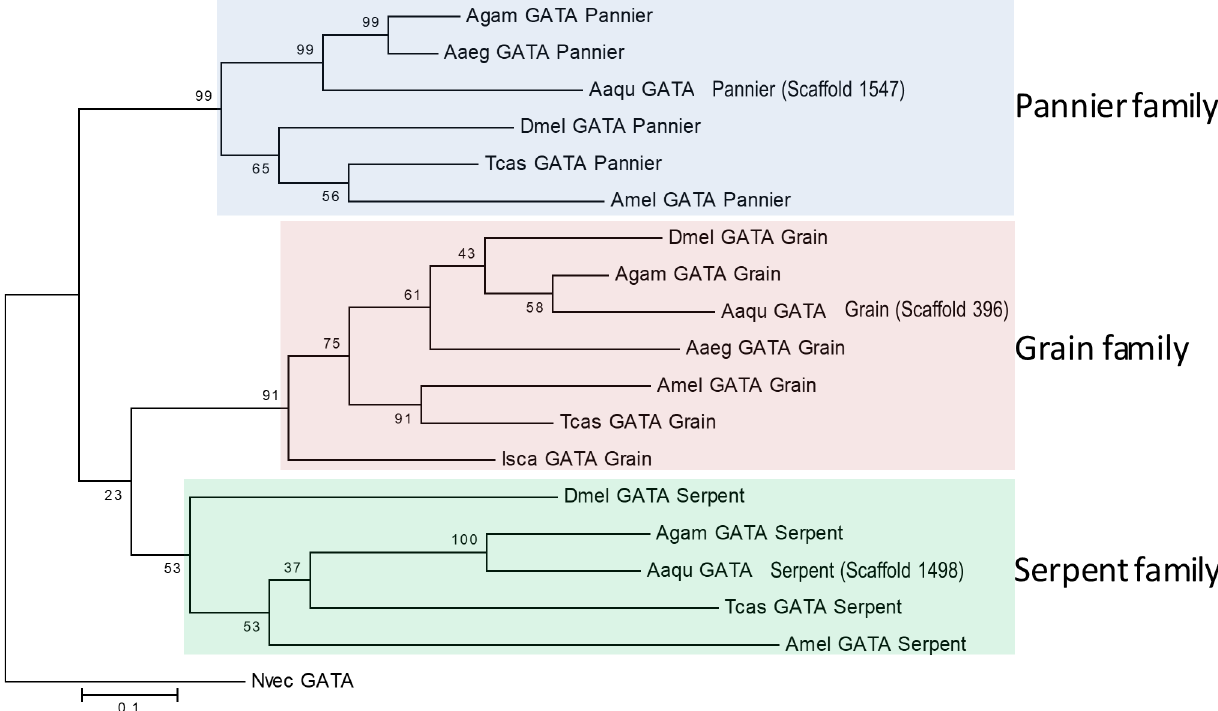
Fig 1. Characterization of A . aquasalis GATA transcription factors. The evolutionary history of GATA genes was inferred using the Neighbor-Joining method. The red arrow points to AaquGATA gene (Scaffold1498). Colored boxes highlight sequences of the three GATA families (Pannier, Grain and Serpent). The percentage of replicate trees in which the associated taxa clustered together in the bootstrap test (2000 replicates) is shown next to the branches. The analysis involved 13 amino acid sequences. All positions containing gaps and missing data were eliminated. There was a total of 139 positions in the final dataset. The accession number for each sequence is included in S1